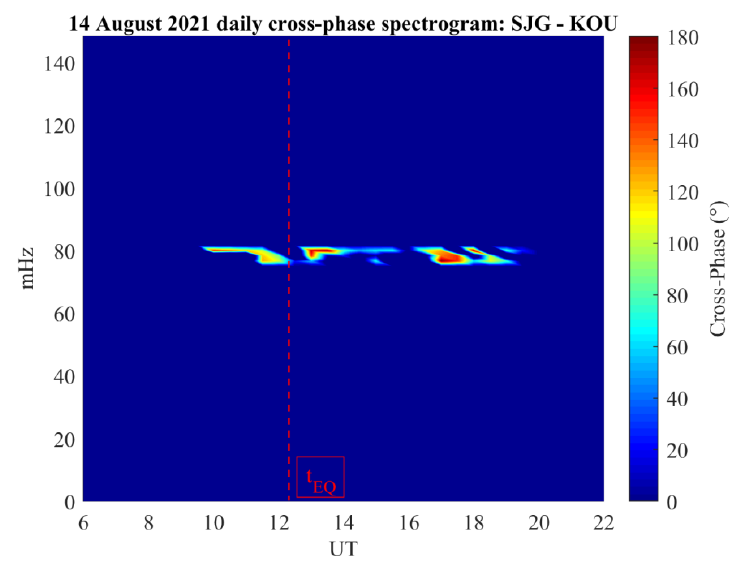
Figure 5. The cross-phase dynamic spectrogram between two low-latitude ground stations near the earthquake epicenter.